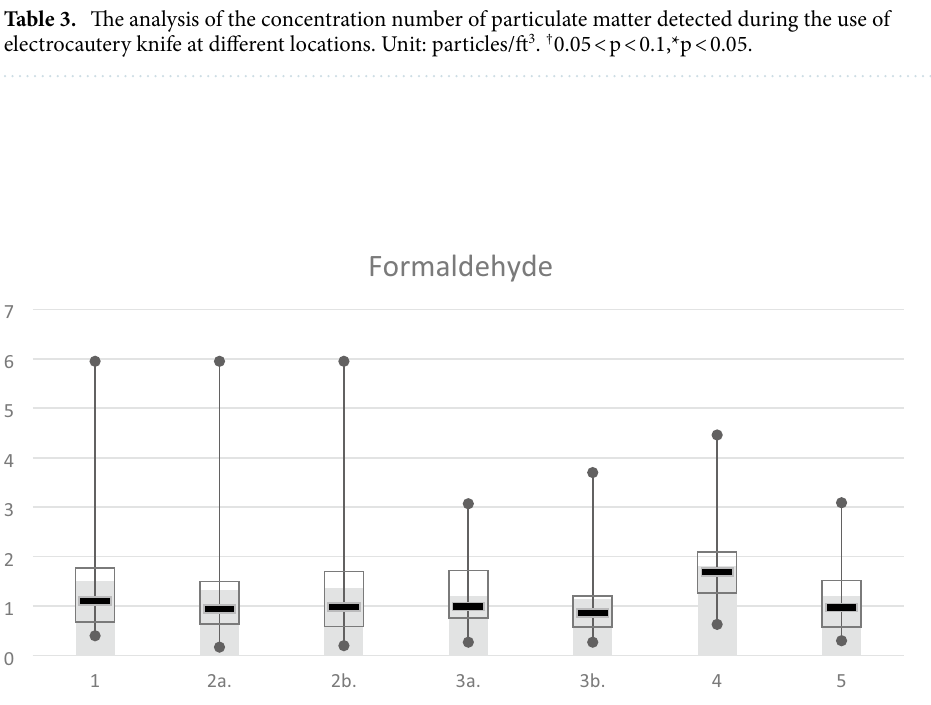
Figure 4. The variation in the average concentration, median value, and interquartile range of the formaldehyde. The horizontal axis is the same as that in Fig.